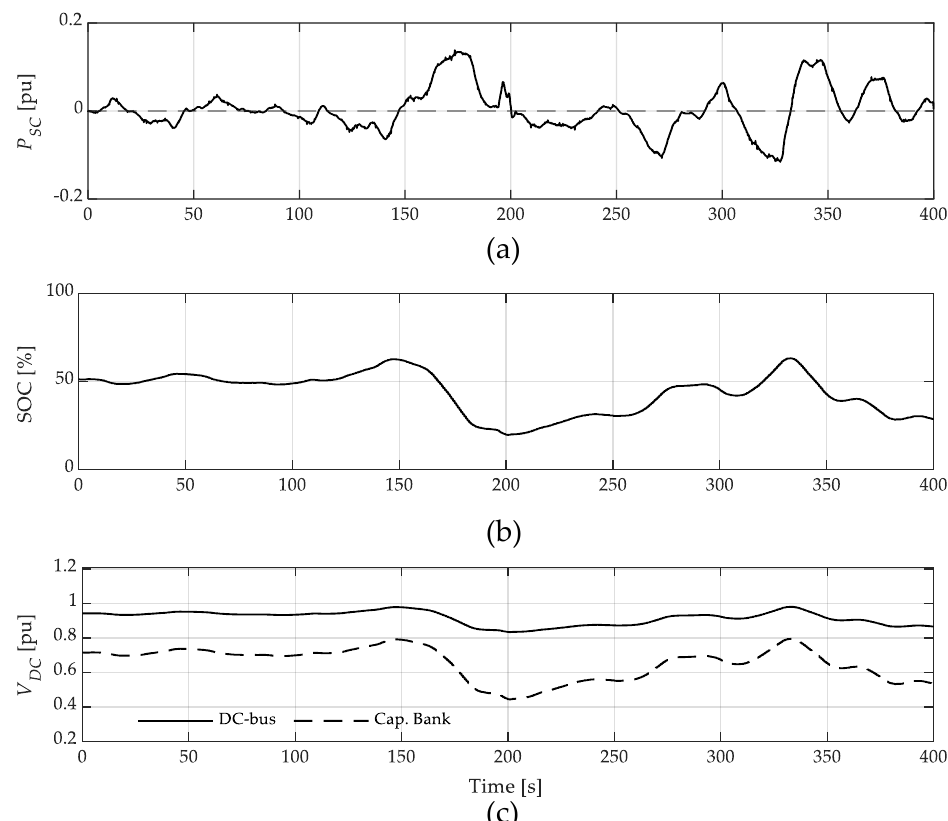
Figure 16. Response of the supercapacitors (SC–ESS) to power fluctuations in Figure 15: ( a ) Active power delivered by the SC–ESS converters, ( b ) evolution of the state of charge of the SC–ESS during smoothing and ( c ) DC voltage of the supercapacitor array upstream of the inverter.